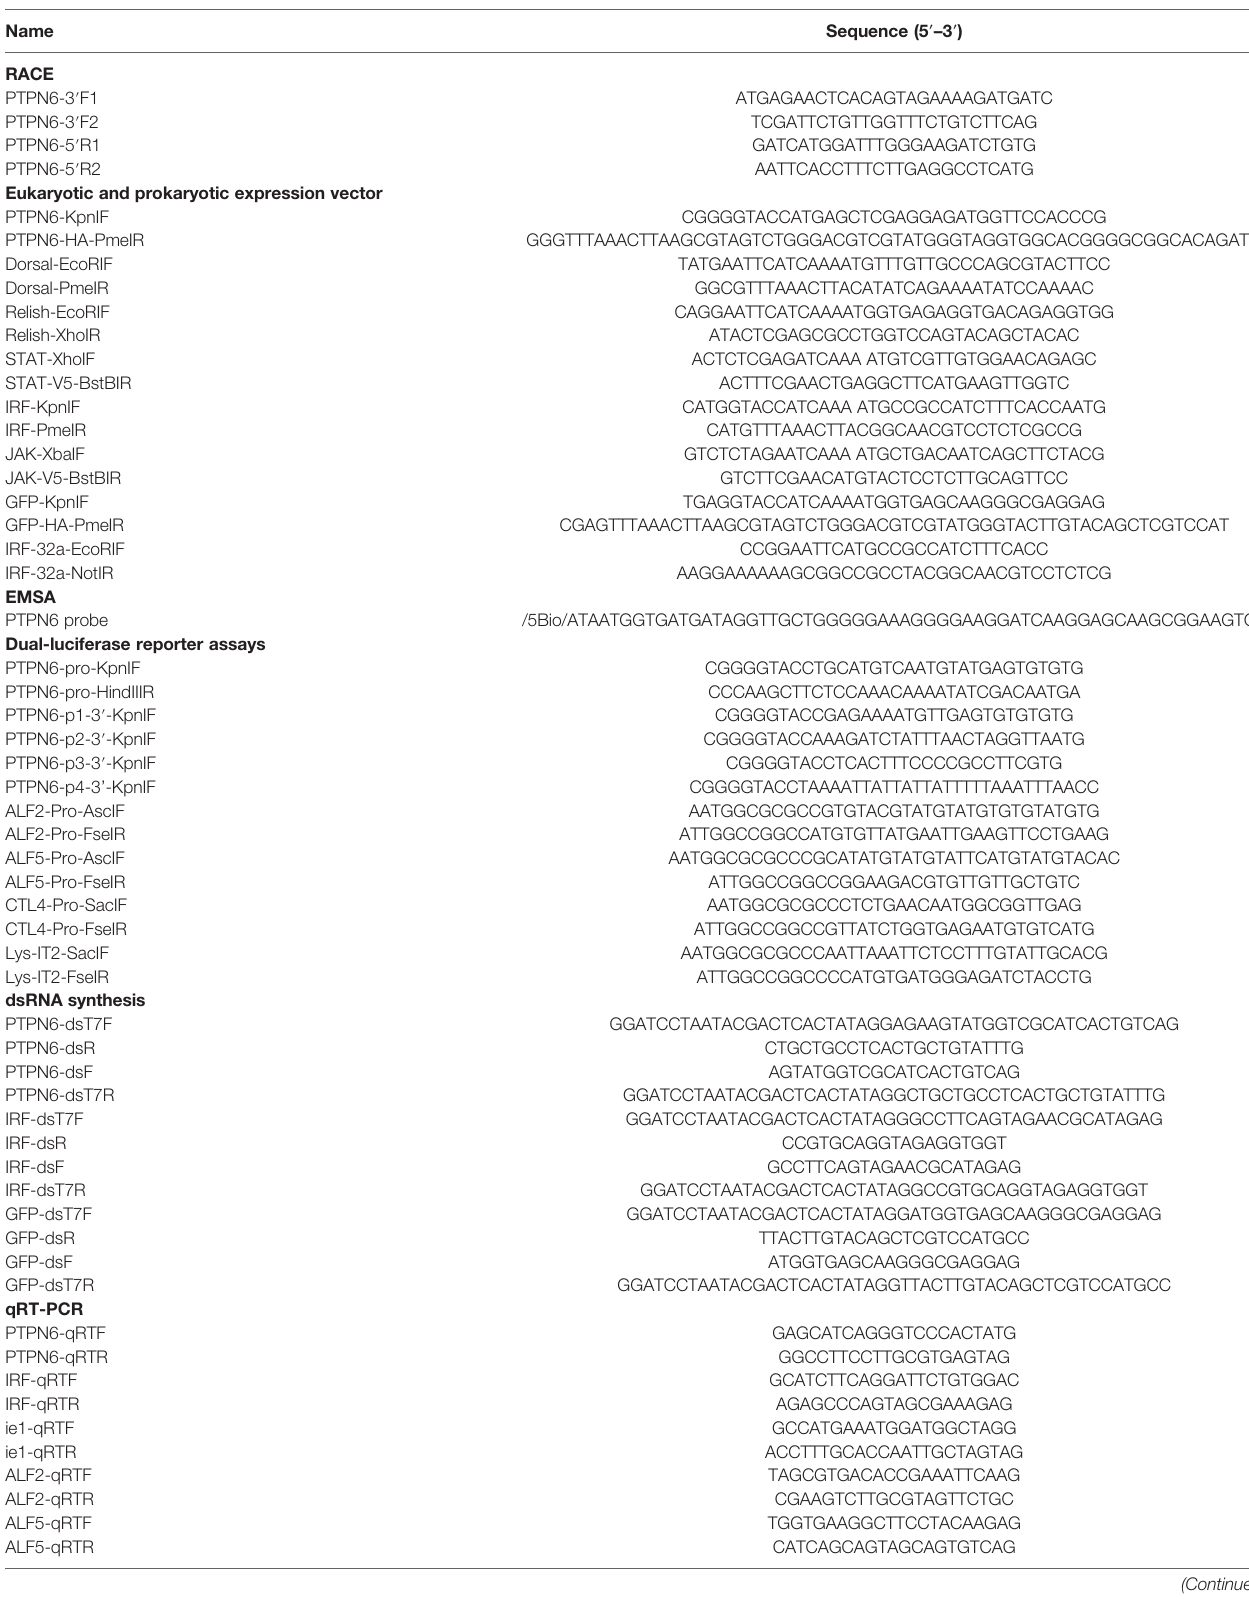
TABLE 1 | Primers and probes used in this